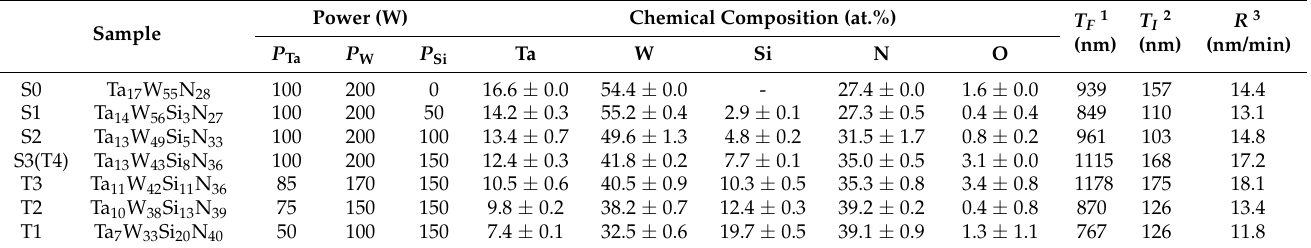
Table 1. Sputtering powers, chemical compositions, and thicknesses of the TaWSiN